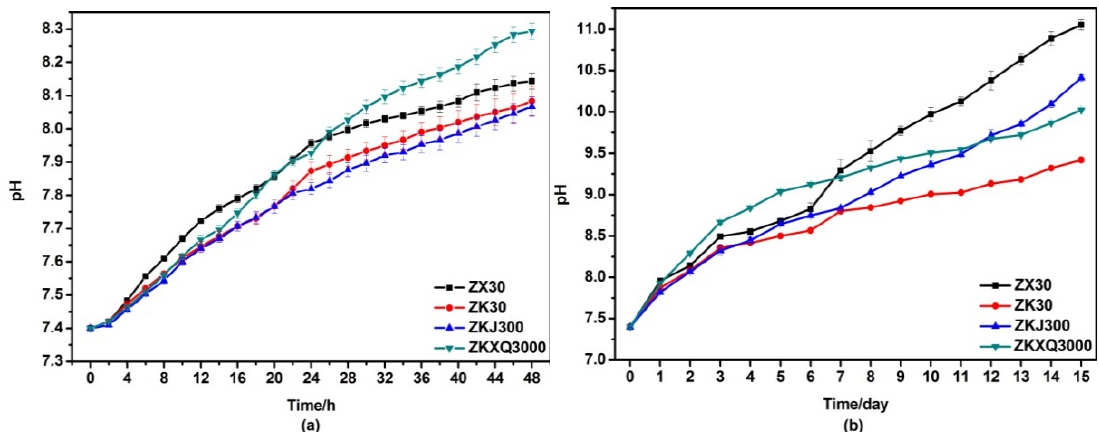
Figure 8. The pH values of the as ‐ extruded ZX30, ZK30, ZKJ300 and ZKXQ3000 alloys immersed for different time. ( a ) pH value of the first 48 h; ( b ) pH value of 15 days.